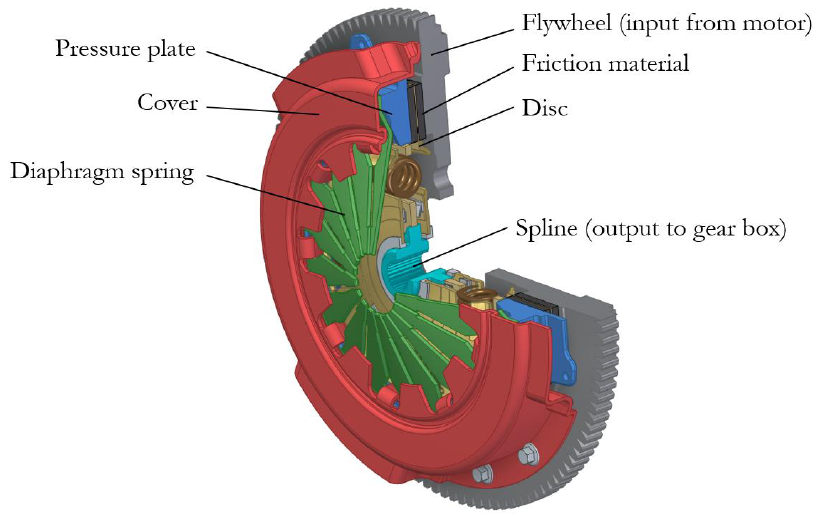
Figure 1. A dry clutch with its most important